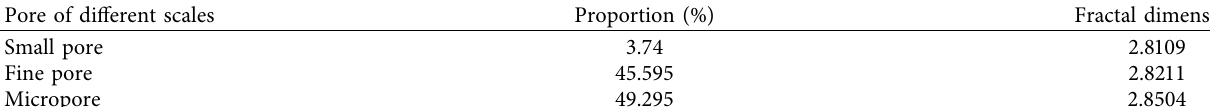
Table 1: Proportions and fractal dimensions of different pores.